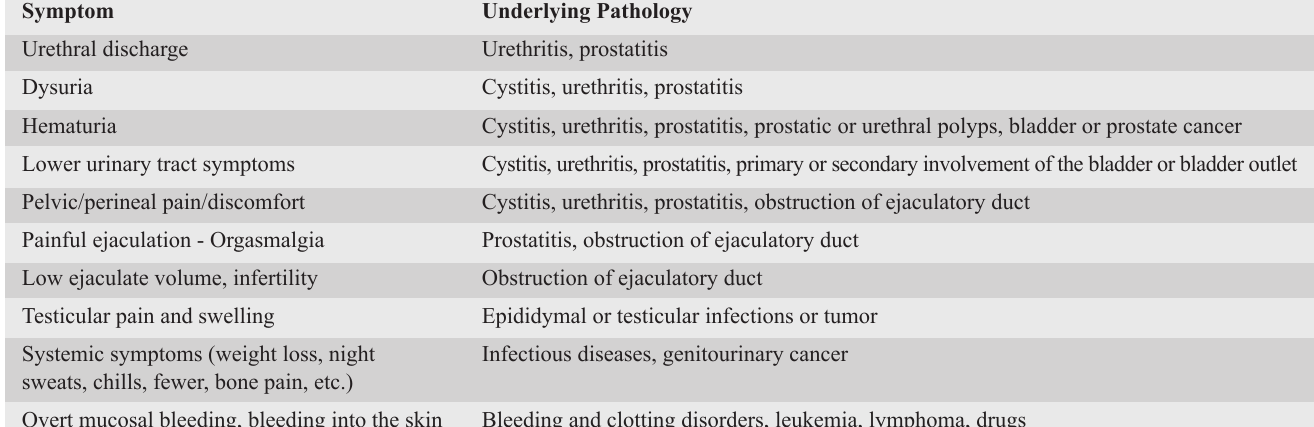
Table 2. Symptoms That Accompany Hematospermia and Possible Causes